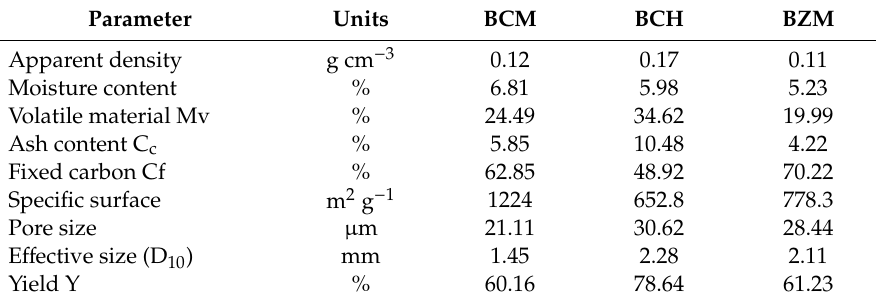
Table 1. Physicochemical characteristics of